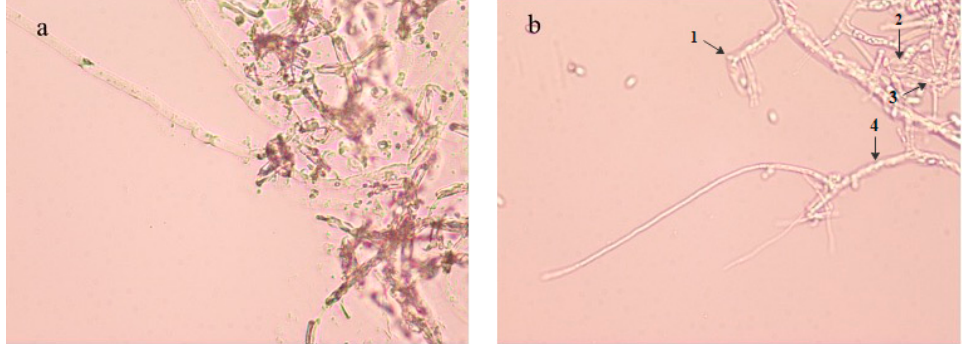
Figure 3. ( a ) The mycelia of Gloeophyllum trabeum of the control group. ( b ) The mycelia of Gloeophyllum trabeum of the treatment group. (1. Broken mycelia. 2. Thickened mycelia. 3. Malformed and distorted mycelia. 4. Leakage of protoplasm).